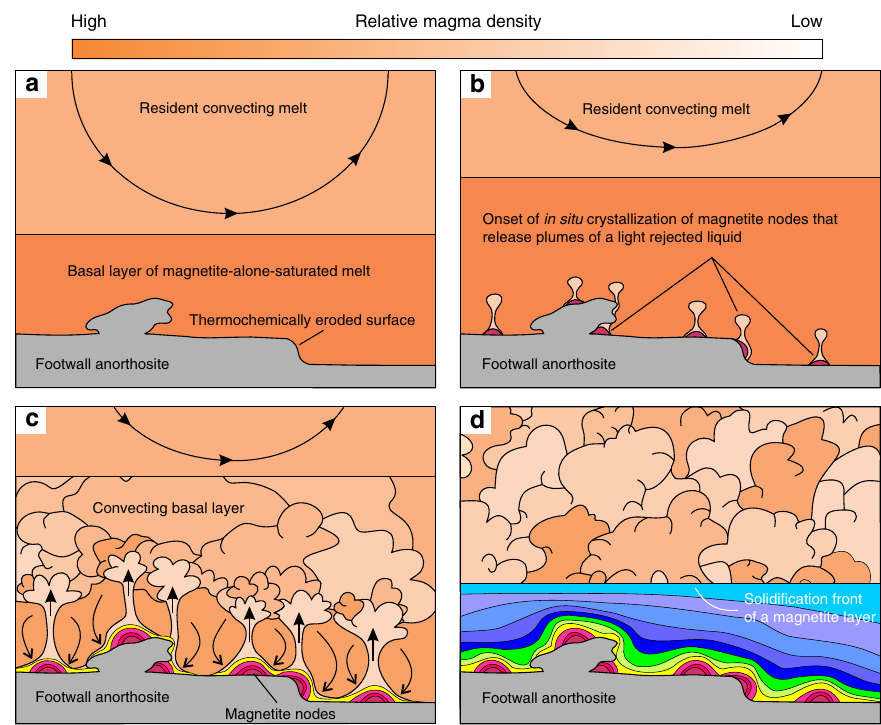
Fig. 9 A physical model for chemical differentiation of the Main Magnetite Layer in the Bushveld Complex (not to scale). a A magnetite-alone- saturated melt is emplaced as a basal layer along the chamber fl oor causing erosion of pre-existing footwall rocks. b On cooling, magnetite starts nucleating on the irregular surface of the anorthositic footwall. c Self-nucleation and crystal growth result in the formation of growth nodes. A residual, buoyant layer of liquid is produced around crystallizing nodes that migrates towards their top and is released into the overlying melt. d Nodes coalesce to form a planar solid fl oor; multiple plumes are released which leads to vigorous mixing in the basal layer. In each progressive step, the basal layer increases in thickness due to further addition of magnetite-alone-saturated melt into the chamber as indicated by geochemical modelling